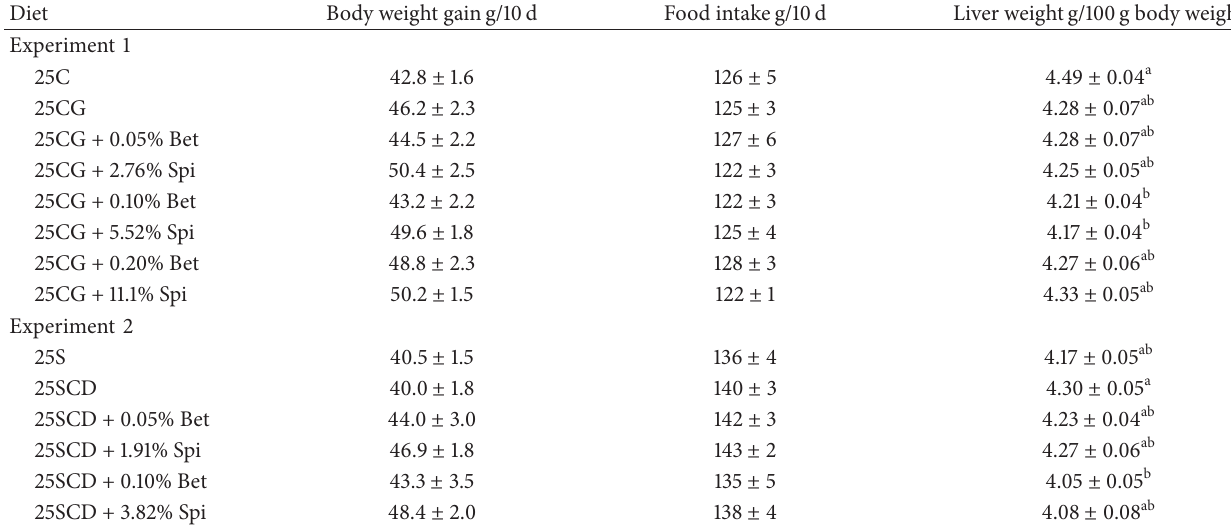
Table 1: Body weight gain, food intake, and liver weight of rats fed the experimental diets (experiments 1 and 2) 1 .